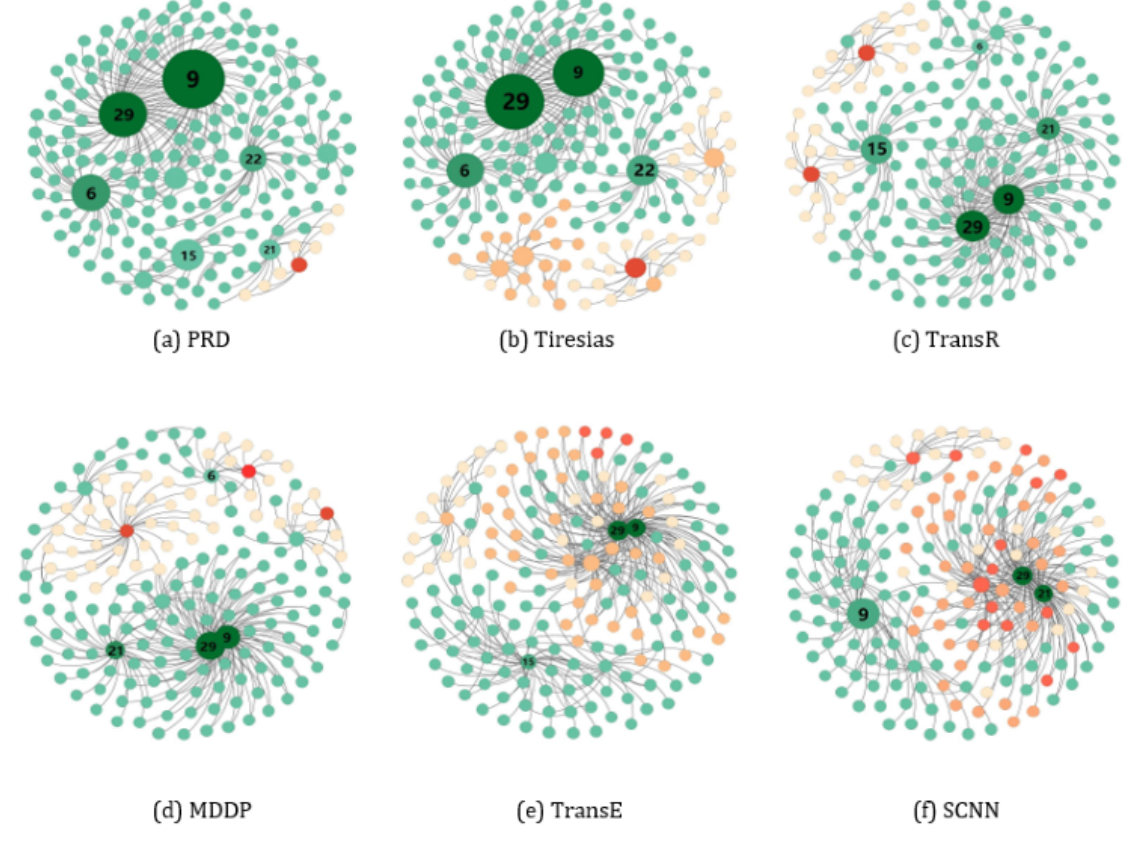
Figure 4. Case visualization of the binary drug-drug interaction-type prediction on a drug-drug interaction network sample. MDDP: multitask dyadic drug-drug interaction prediction; PRD: Predicting Rich Drug-Drug Interaction; SCNN: Syntax Convolutional Neural